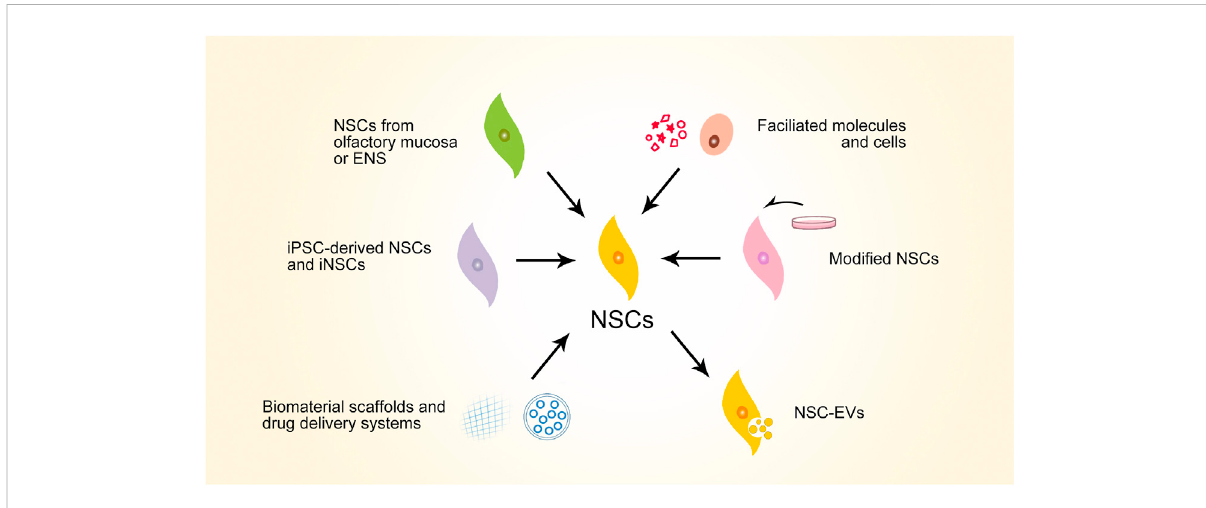
FIGURE 3 Schematic overview of major preclinical progresses of NSC-based strategies for SCI repair. NSCs, neural stem cells; ENS, enteric nervous system; iPSC, induced pluripotent stem cells; iNSCs, induced neural stem cells; NSC-EVs, NSC-derived extracellular